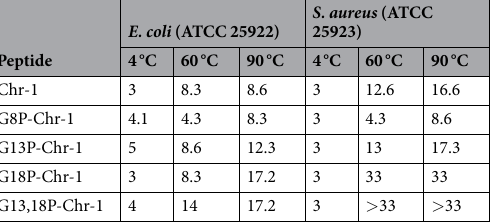
Table 5. Antibacterial activity of Chr-1 and its variants (in μ M) against E. coli and S. aureus after incubating at different temperatures.